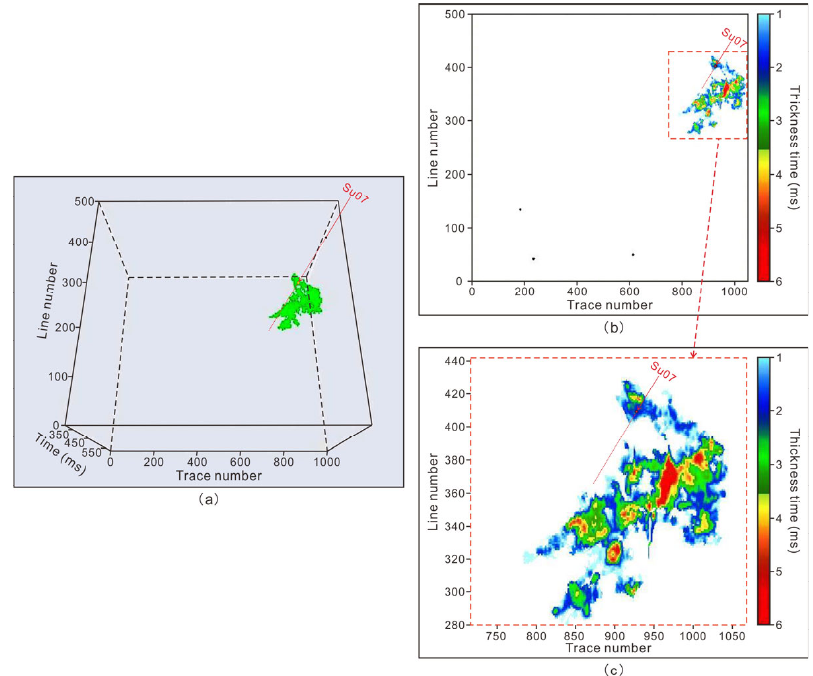
Figure 10. The 3D spatial range and its plane distribution characteristics along the target stratum of the sand body with uranium around Well Su07: ( a ) 3D spatial range, ( b ) Plane distribution characteristics extracted along the target stratum, ( c ) Local enlargement of the red rectangular dashed box in ( b ).